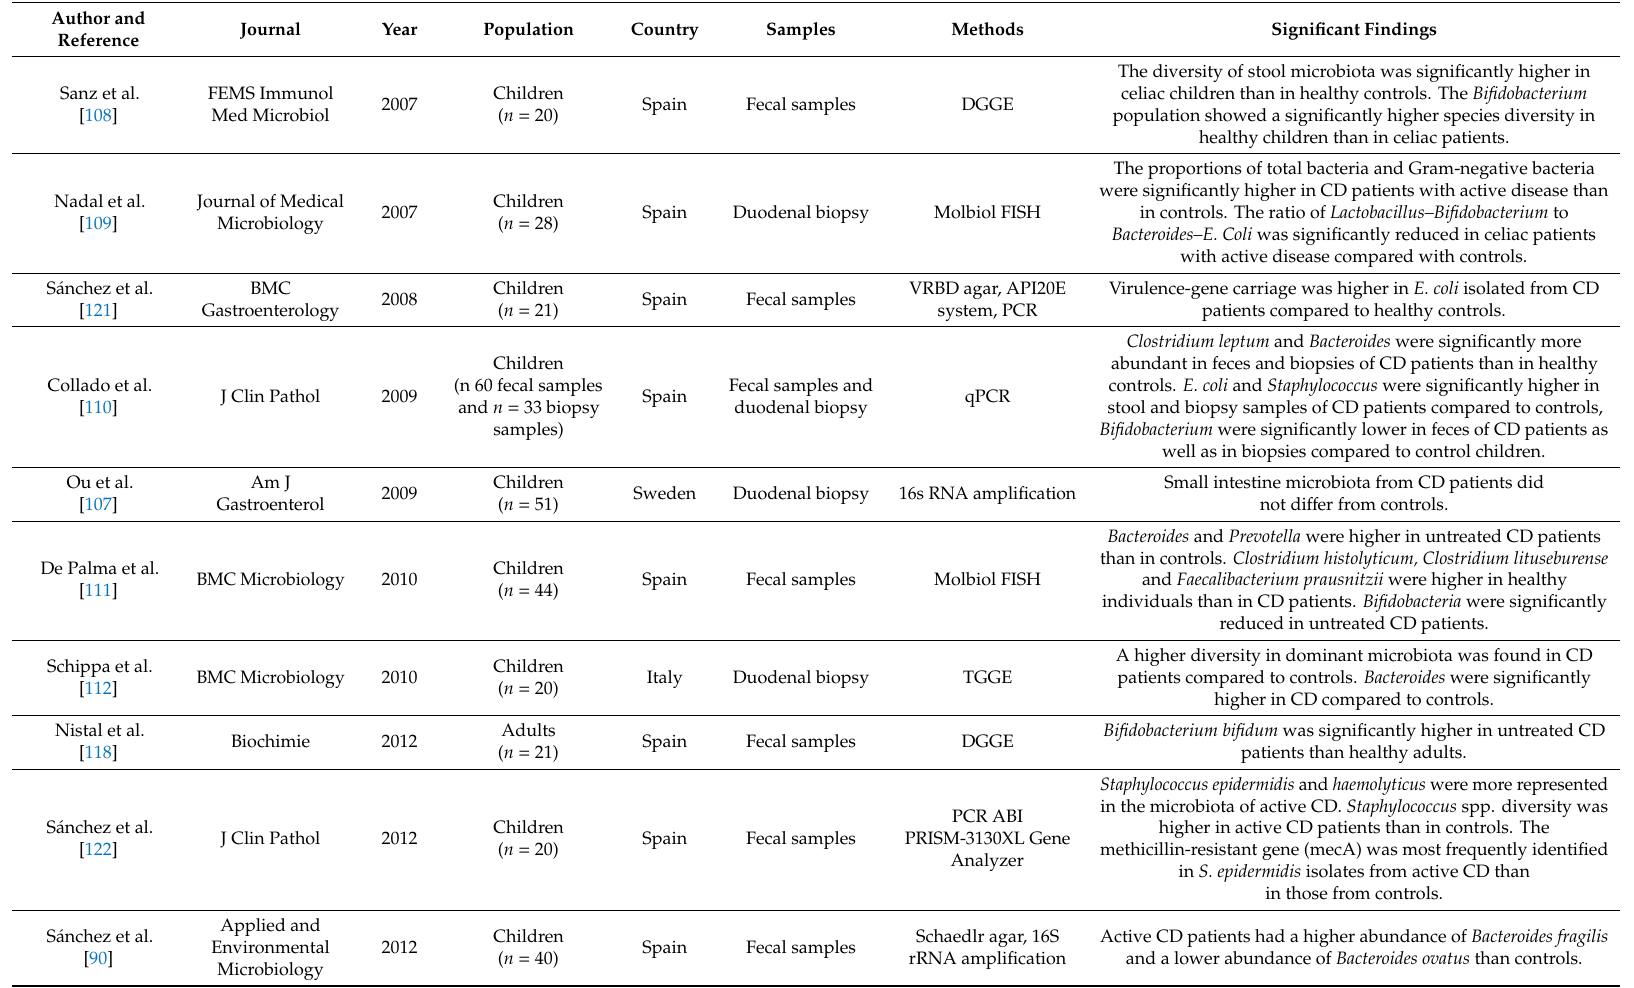
Table 1. Cross-sectional studies on Microbiota and subjects with celiac disease